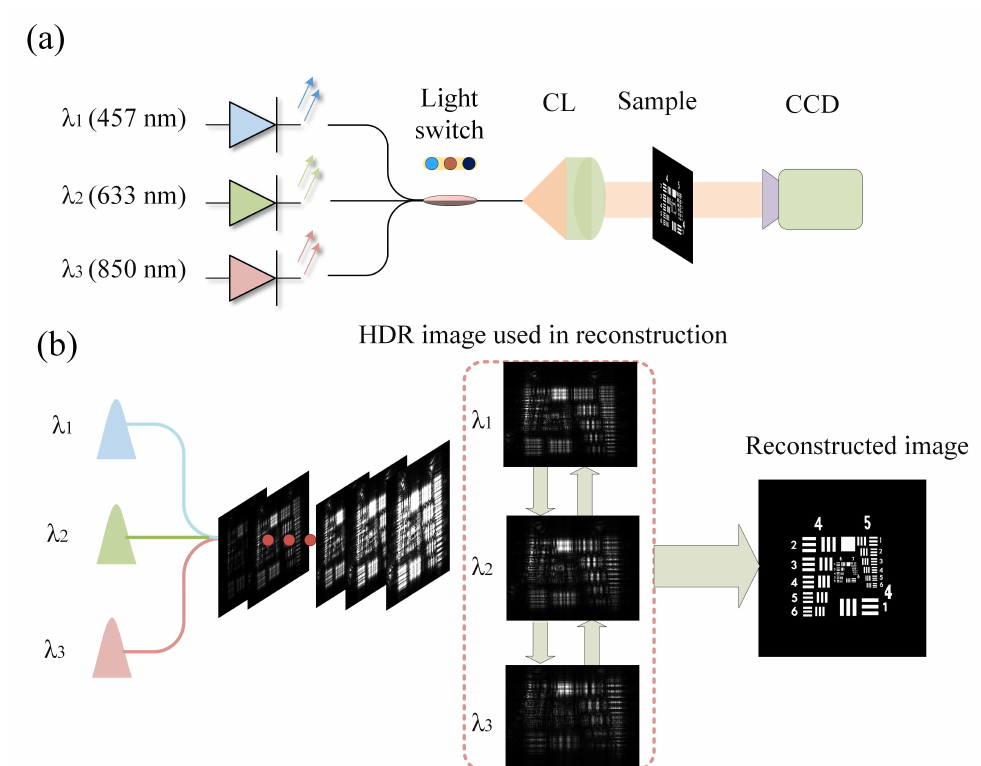
Figure 2. ( a ) The optical setup of the experiment. CL, collimator. Light switch, a light switch is used for laser on and off. ( b ) HDR diffraction images used in multi-wavelength diffraction imaging system to improve the